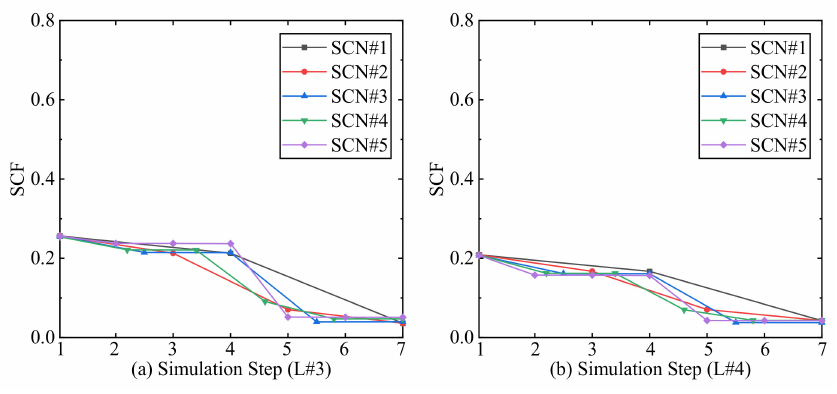
Figure 8. SCF of sidewall middle of level #3 and level